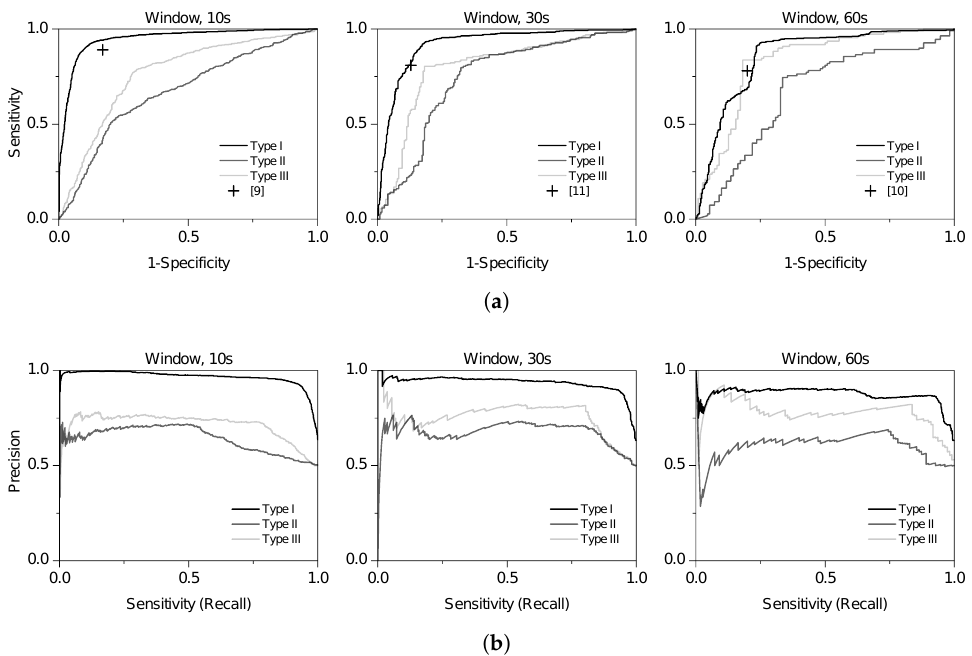
Figure 5. ROC and PR curves. Each line represents a curve from Type I, Type II, and Type III training, respectively. A cross refers to the performances of the conventional model. ( a ) ROC curves and ( b ) PR